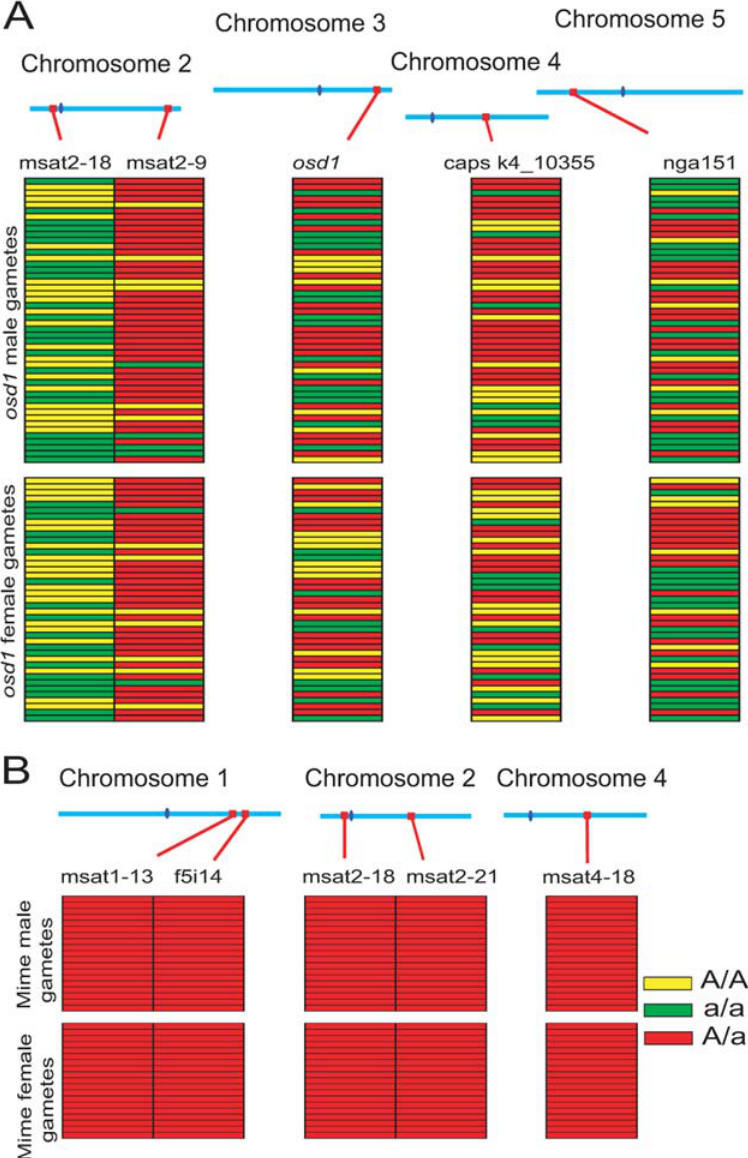
Figure 5. Genetic make-up of the osd1 and MiMe diploid gametes. (A) Triploid offspring of the osd-1 (No-0)/ osd1-2 (Ler) 6 Col-0 crosses were genotyped for several molecular markers. Each line represents one plant. For each marker, plants carrying only the No-0 allele are in green, plants carrying only the Ler allele are in yellow, and plants with both the No-0 and Ler alleles are in red. Col-0 alleles are present in all the plants because it was used as the male or female parent in the cross. The position of each marker (red) and the centromeres (dark blue) are indicated along the chromosomes. (B) Similarly, triploid offspring of the MiMe (patchwork of Col-0 from Atspo11-1/Atrec8 and No-0 from osd1-1 ) 6 Le crosses was genotyped for molecular markers that were heterozygous in the MiMe mother plant. All the plants were heterozygous for each marker (Col-0/No-0).